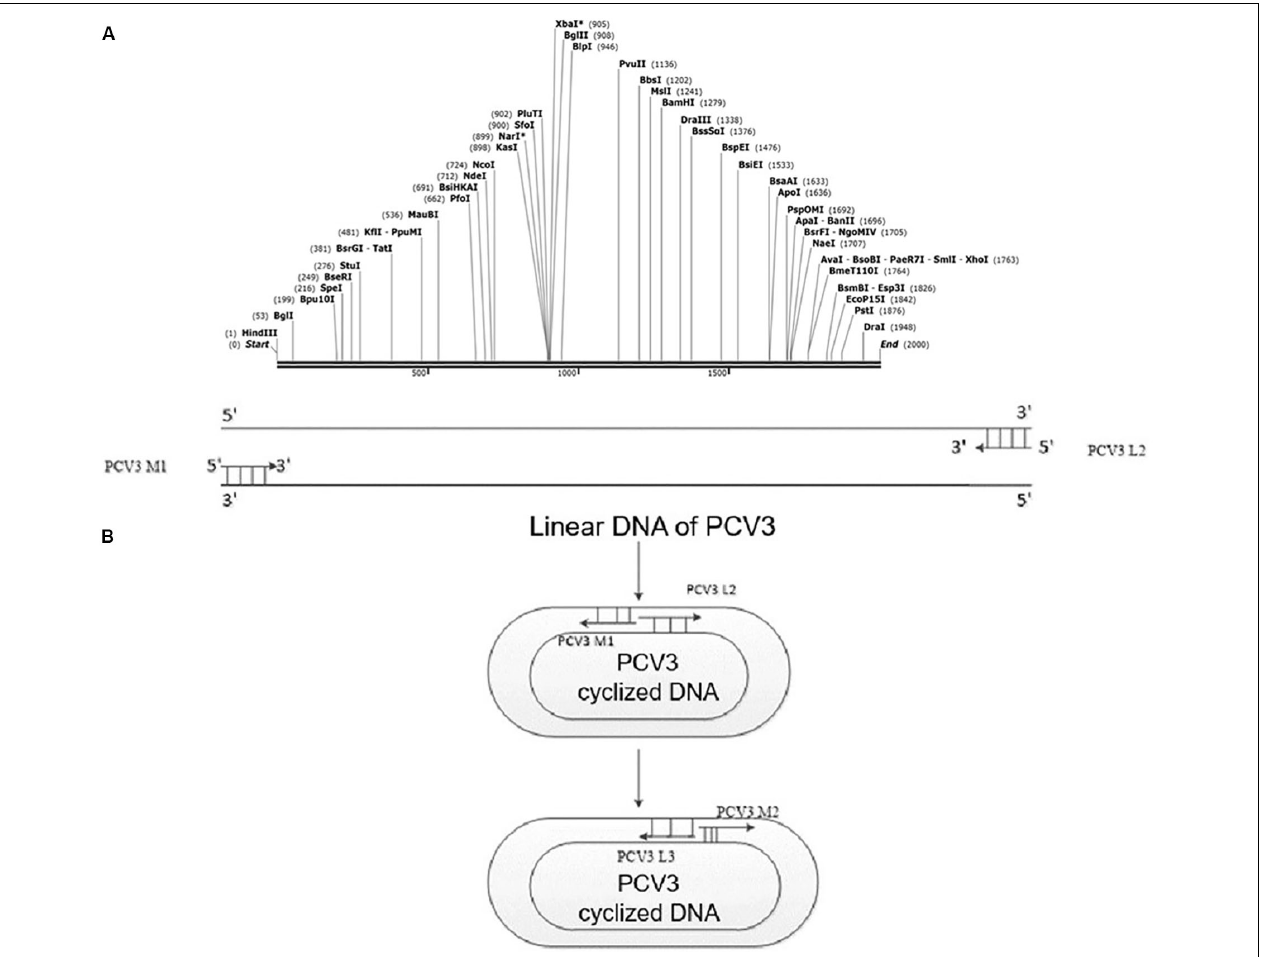
FIGURE 1 | PCV3 viral gene rearrangement. (A) Rearranged linear gene sequence of PCV3 containing Hin dIII restriction sites. The Hin dIII restriction site acted as the reopening site, added to the end of the linear sequence after the opening process. (B) PCR detection after PCV3 cyclization. Specific primers, covering PCV3 M2 and PCV3 L3, were designed to verify whether the PCV3 gene sequence was cyclized. However, the PCV3 linear sequence could not be amplified by the mentioned primers.